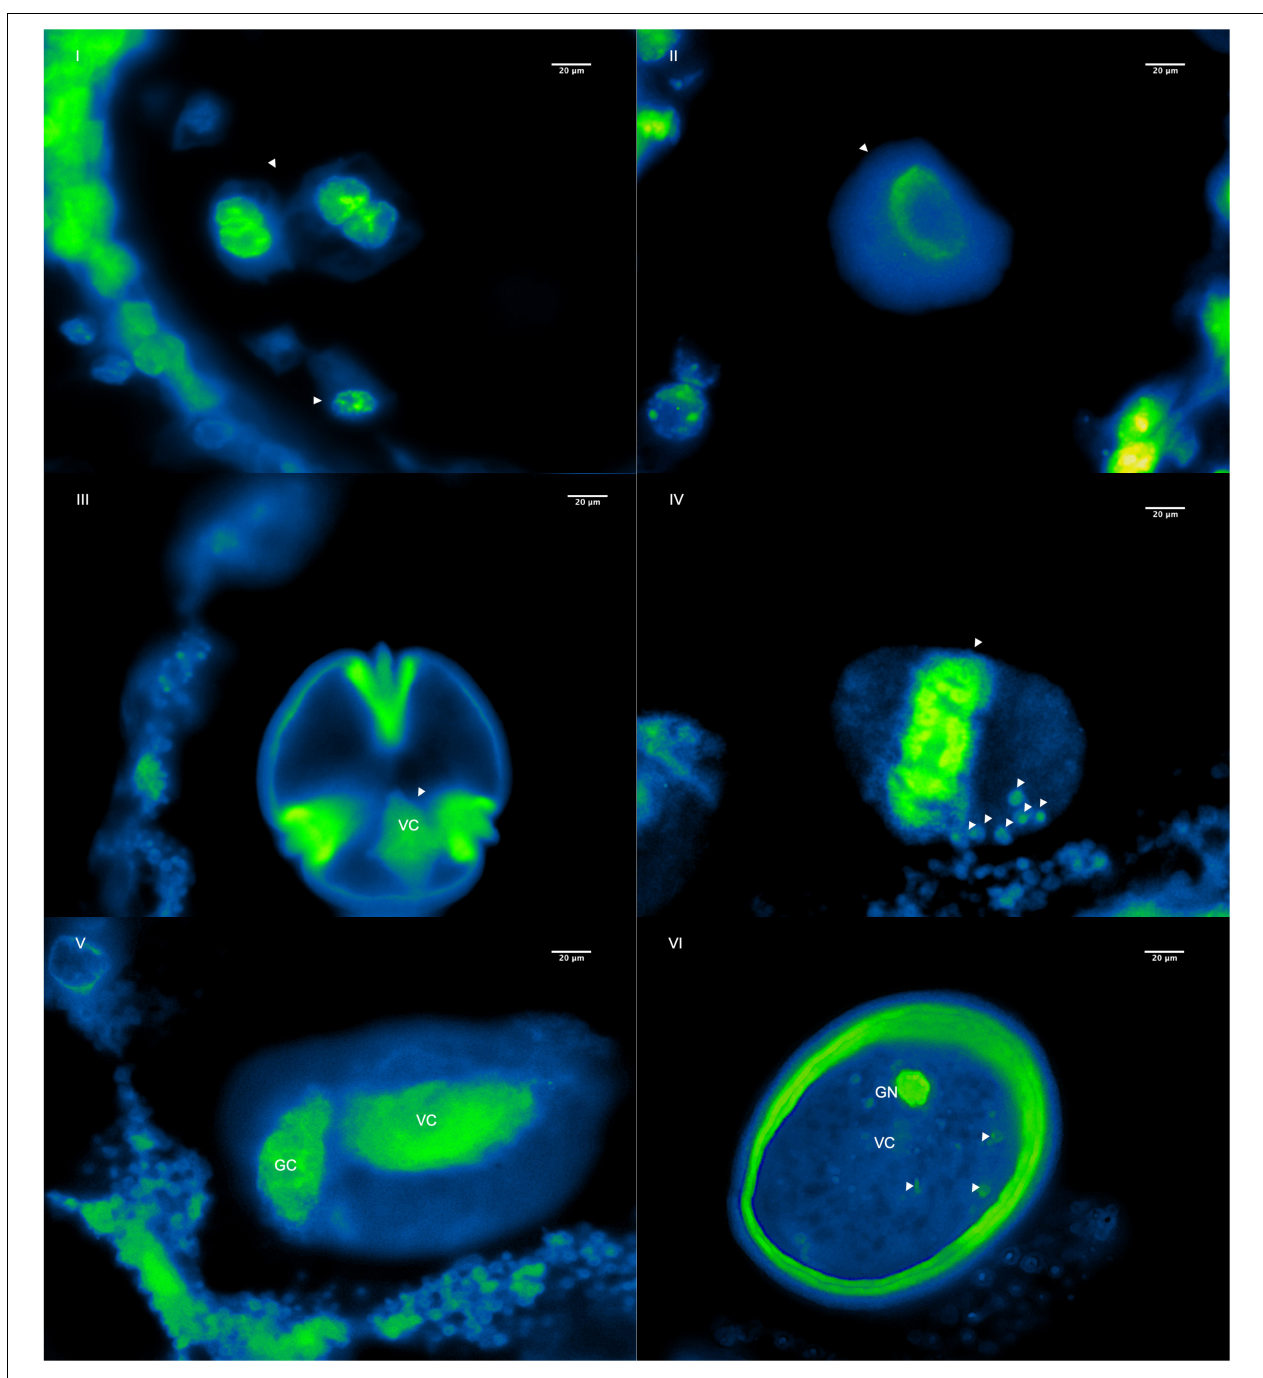
FIGURE 5 | Six morphological stages of microsporogenesis and microgametogenesis are shown during the first four flower buds developmental stages of pollen cells of P. volubilis using fluorescent micrograph and DAPI stain. (I) First meiosis and formation of tetrads, (II) microspore release, (III) microspore during interphase, (IV) microspore undergoing the first pollen mitosis (PMI) and trafficked fluorescent oDNA granules (pointed out with the arrows), (V) formation of a generative cell (GC) and vegetative cell (VC), and (VI) mature pollen and cytoplasmic DNA decay and formation of the final MGU before anthesis. All observations are at 100X.